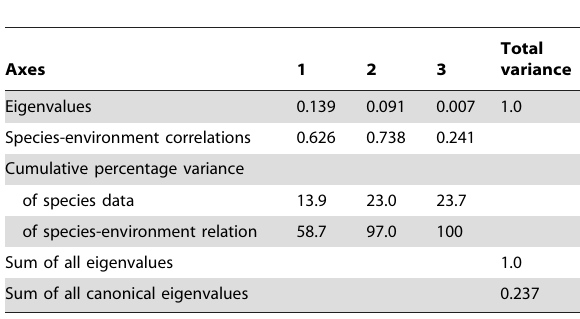
Table 2. Results of redundancy analysis (RDA) on log- transformed data on fish biomass, benthic biomass and cover of bare rock, and environmental and human-related variables.